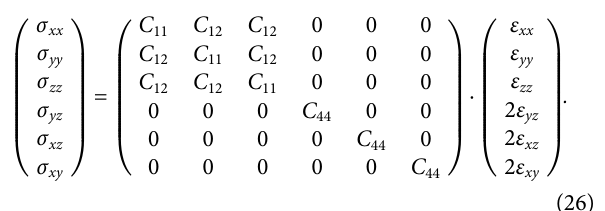
FIGURE 2 | The complex-valued amplitude ratio of normal re fl ection, R j , is determined by the boundary-bulk stiffness ratio, K j / C 11 , and wave number k